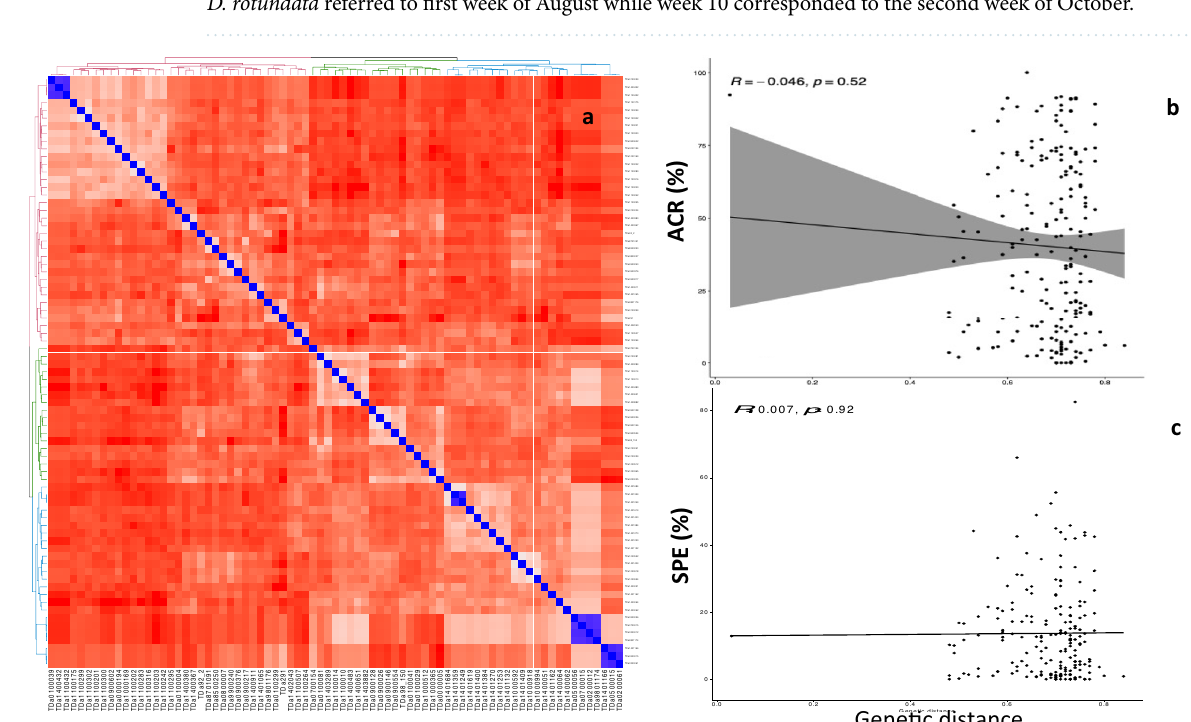
Figure 4. Genetic relatedness among D. alata genotypes using SNP information: (a) Heatmap IBS genetic distance, and influence on (b) average crossability rate (ACR) and (c) seed production efficiency (SPE) in D. alata